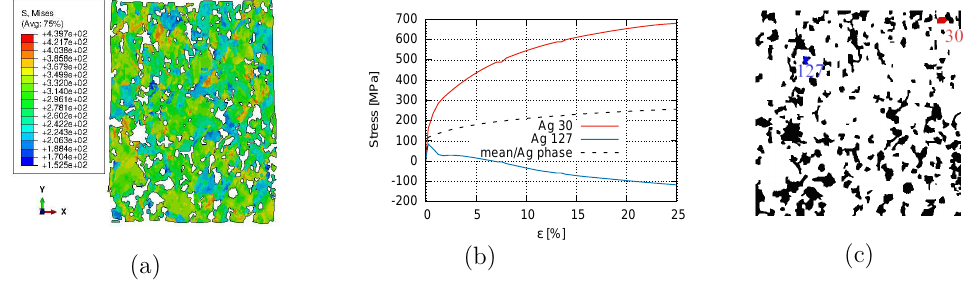
Figure 9. Comparison of the experimental [14] and homogenized σ PM12-3 Ag/SnO 2 composite.